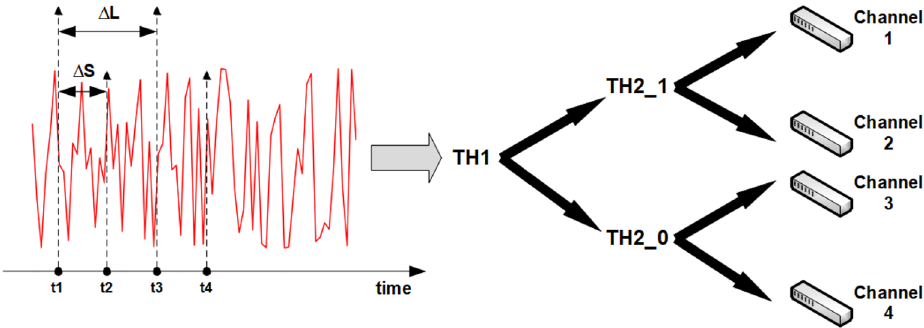
Figure 4. The process of using the laser chaos series to select the corresponding channel when M =2.